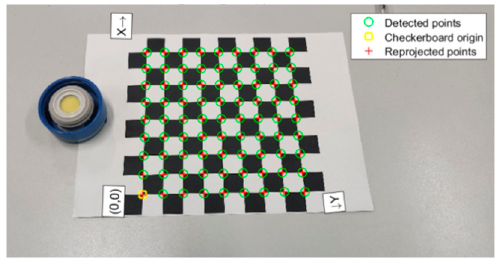
Figure 8. Camera calibration.